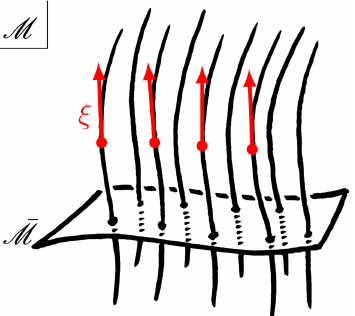
Figure 2. A principal R -bundle ( M (cid:16) ¯ M , ξ ) . Each curve is a fibre, and all points of that fibre are mapped by the projection (3.1) on a single point on the base ¯ M . The bundle M is locally R , but in the case at hand this is even true globally, thanks to the isomorphic to a product ¯ M × global existence of a smooth ( R , +) group